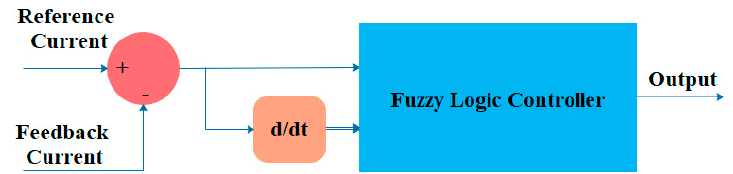
Figure 31. Voltage control block for hybrid controller-3.